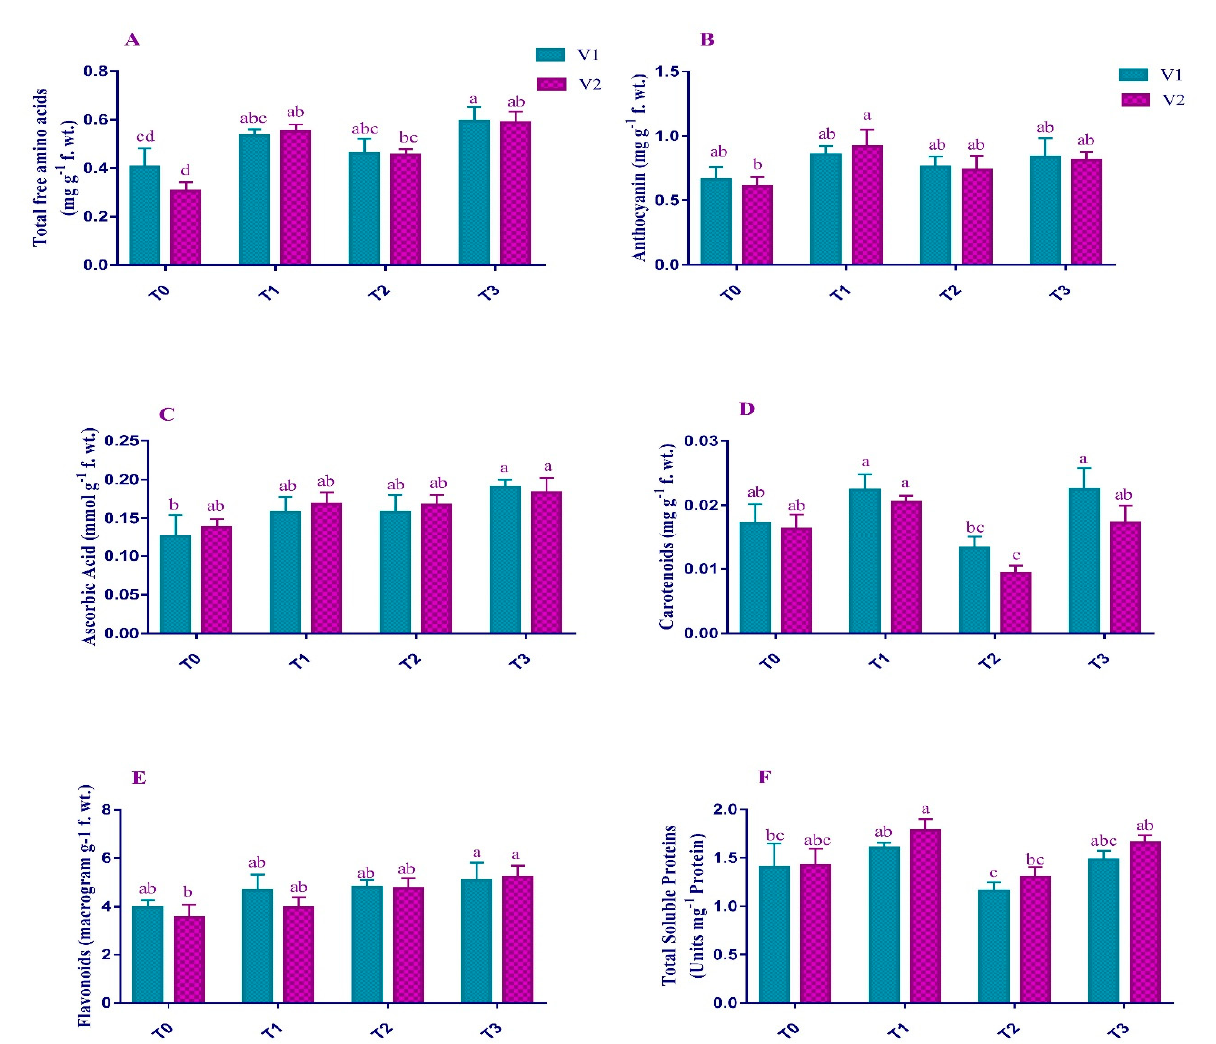
Figure 4. Effect of Pb and EDTA on ( A ) total free amino acids (mg g − 1 f. wt.), ( B ) anthocyanin (mg g − 1 f. wt.), ( C ) ascorbic acid (mmol g − 1 f. wt.), ( D ) carotenoids (mg g − 1 f. wt.), ( E ) flavonoids (µg g − 1 f. wt.) and ( F ) total soluble proteins (Units mg − 1 Proteins) of brown mustard. Error bars above means indicate the ± SE of three replicates. Means sharing a letter for a parameter do not differ significantly at p ≤ 0.05. V1 = Faisal cultivar; V2 = Rohi cultivar; T 0 = 0 mM EDTA + 0 mM Lead acetate; T 1 = 2.5 mM EDTA + 0 mM Lead acetate; T 2 = 0 mM EDTA + 0.5 mM Lead acetate; T 3 = 2.5 mM EDTA + 0.5 mM Lead